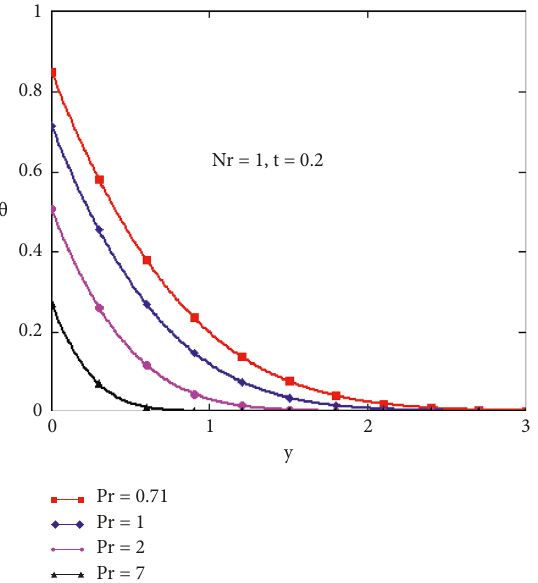
Figure 6: Temperature profile for different values of Pr.